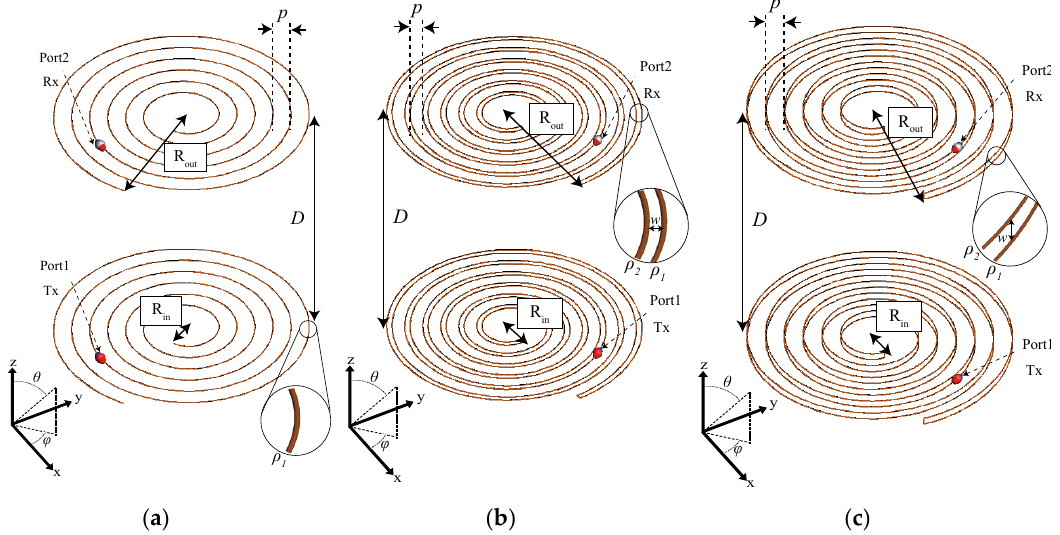
Figure 3. Simulation models: ( a ) Spiral resonator; ( b ) Single-layered folded spiral resonator; ( c ) Double-layered folded spiral resonator.